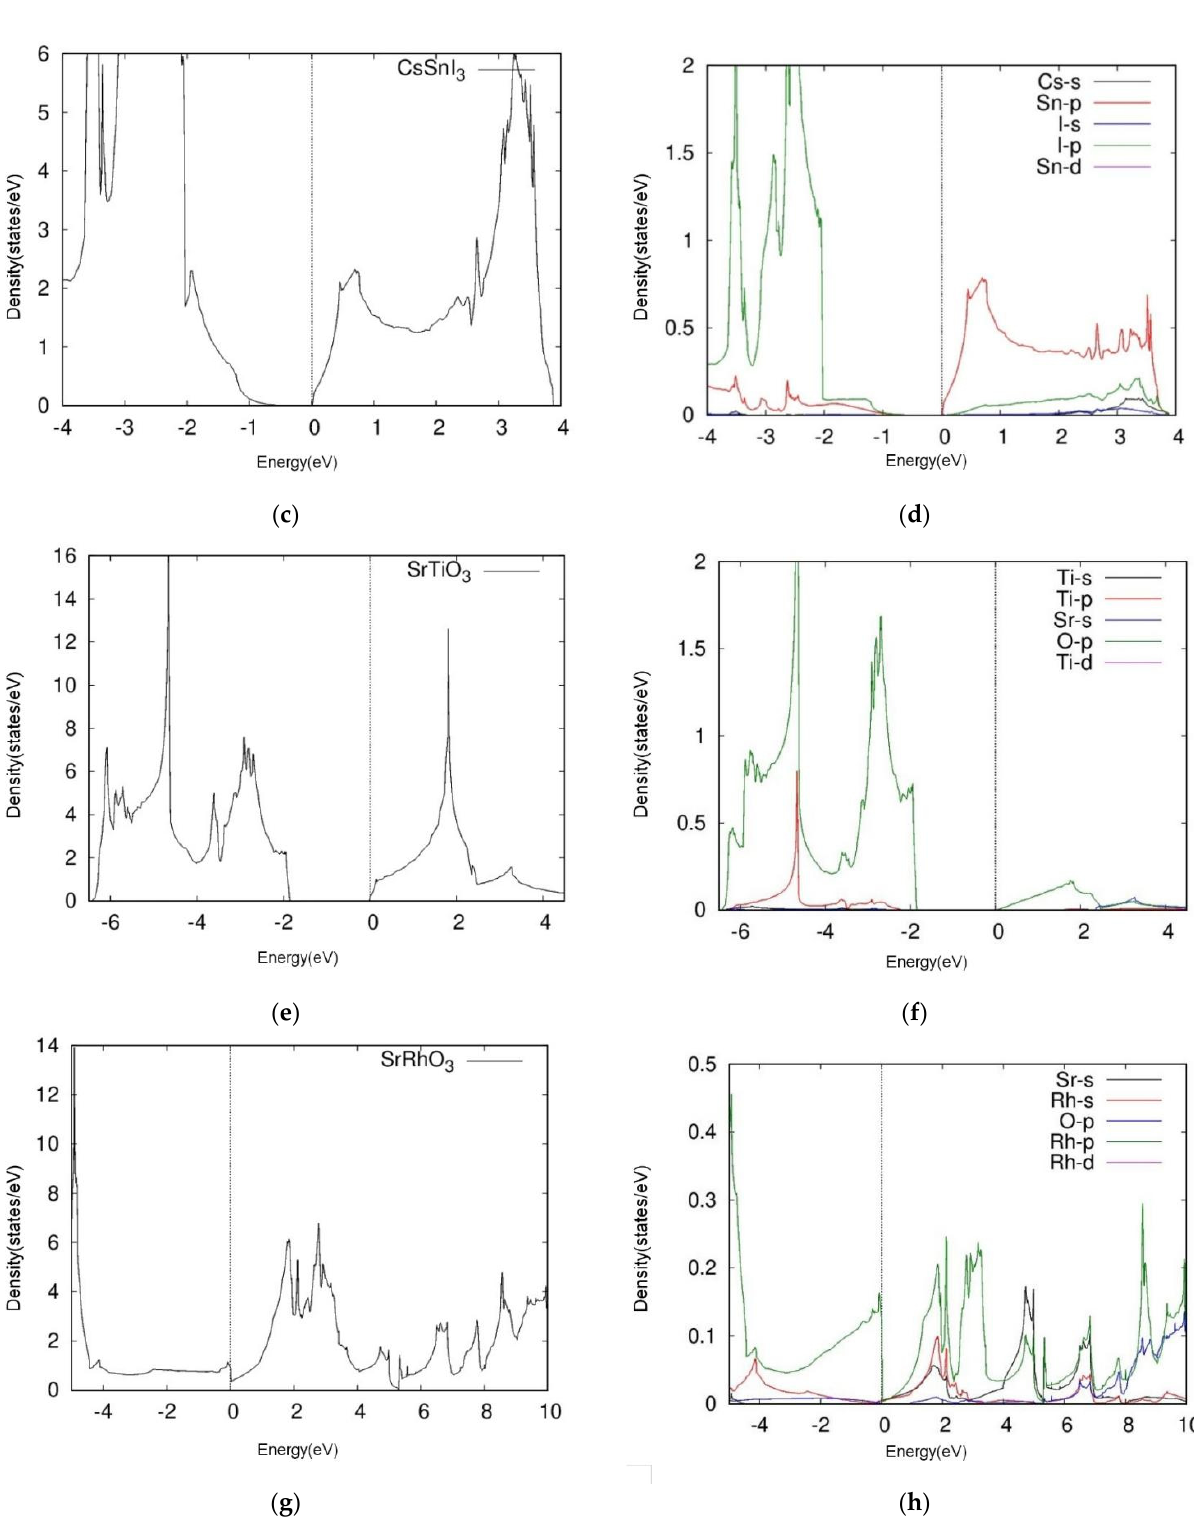
Figure 3. Total DOS (left) and projective (right) DOS of four kinds of cubic perovskites ( a,b ) and CsSnCl 3 , ( c , d ) CsSnI 3 , ( e , f ) SrTiO 3 , ( g , h ) SrRhO 3 . We calculated the A-s, B-p, B-d, X-s, and X-p orbitals of ABX 3 cubic perovskites.